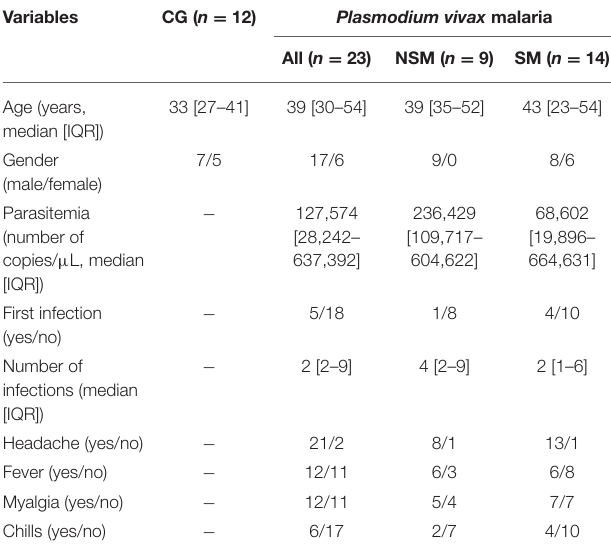
TABLE 1 | Demographic, parasitological, and baseline clinical characteristics of Control Group (CG) and Pv -malaria patients that did Not Self-Medicate (NSM) and Self-Medicated